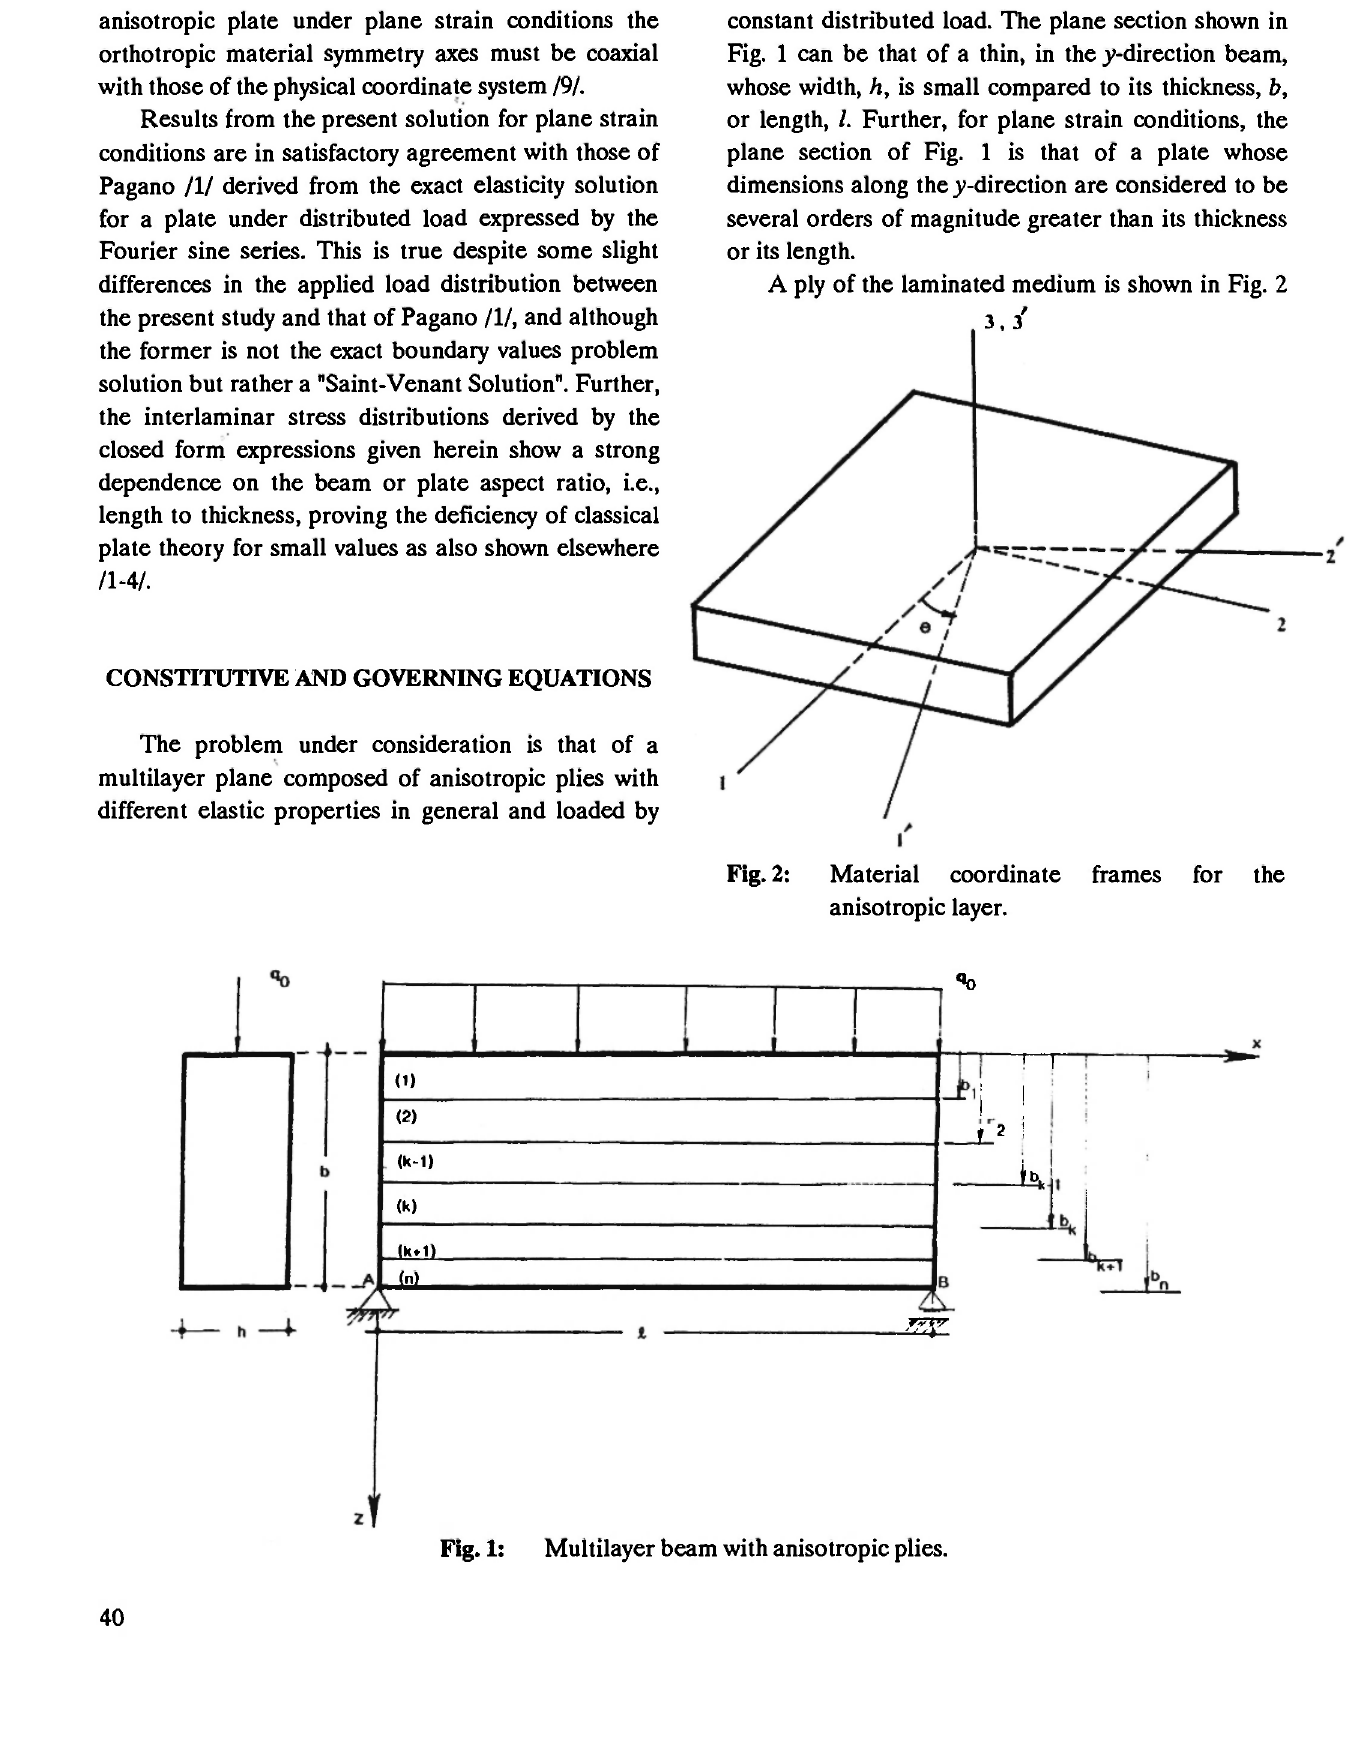
Fig. 2: Material coordinate frames for the anisotropic layer.